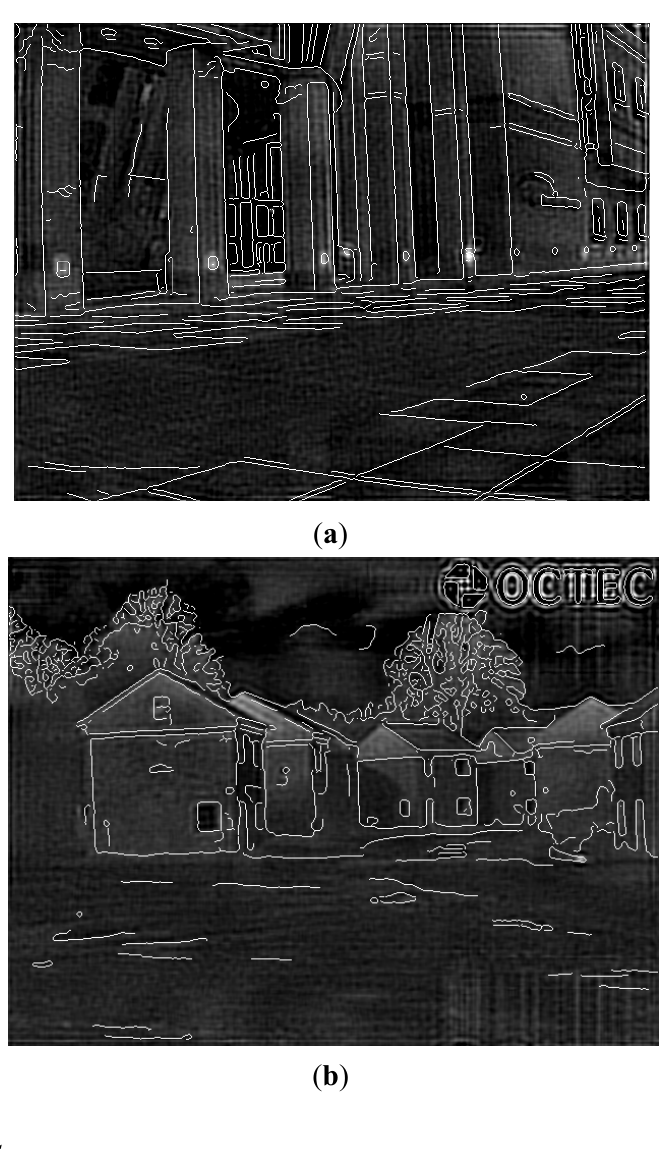
Figure 5. Examples of superimposed images. ( a ) Indexing superimposed result of the transformed IR Image 1; ( b ) Indexing superimposed result of the transformed IR Image